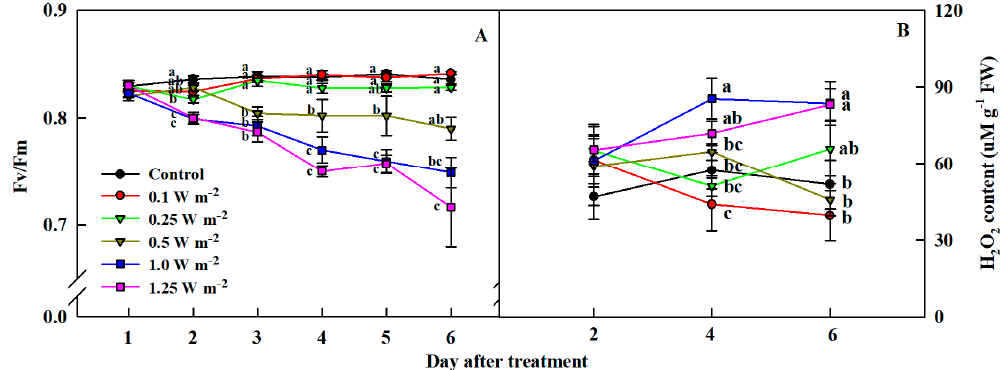
Figure 3. Maximum quantum yield of photosystem II (Fv/Fm) ( A ) and H 2 O 2 content ( B ) of C. denticulatum subjected to five energy levels of UV-B radiation for 6 days. The UV-B treatments started after 5 weeks of transplanting. Different letters next to bars indicate a significant difference by Duncan’s multiple range test at p < 0.01 (Fv/Fm, n = 5; H 2 O 2 content, n = 6).